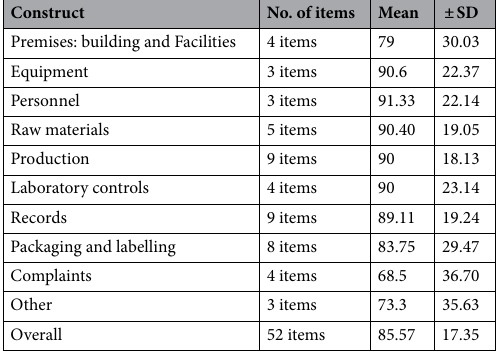
Table 3. Descriptive statistics for the questionnaire dimensions.